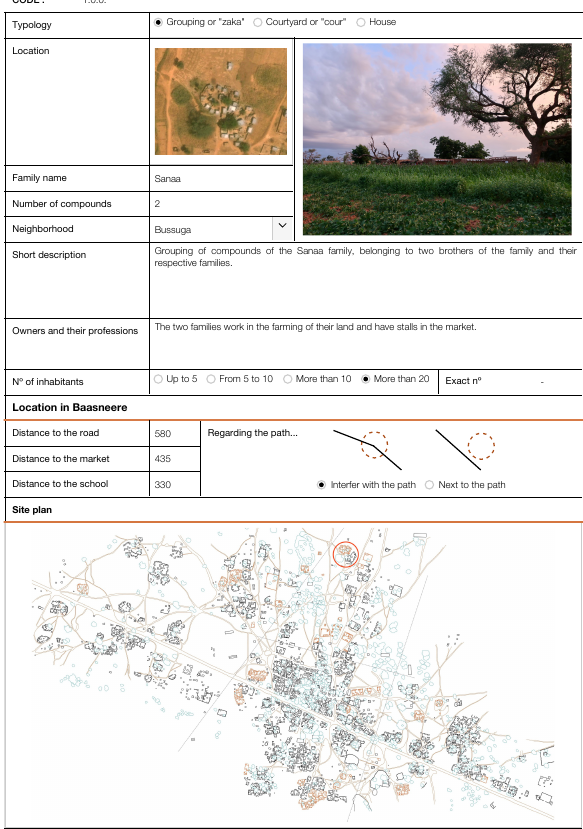
Figure 2. Fiche A: Social and urban analysis